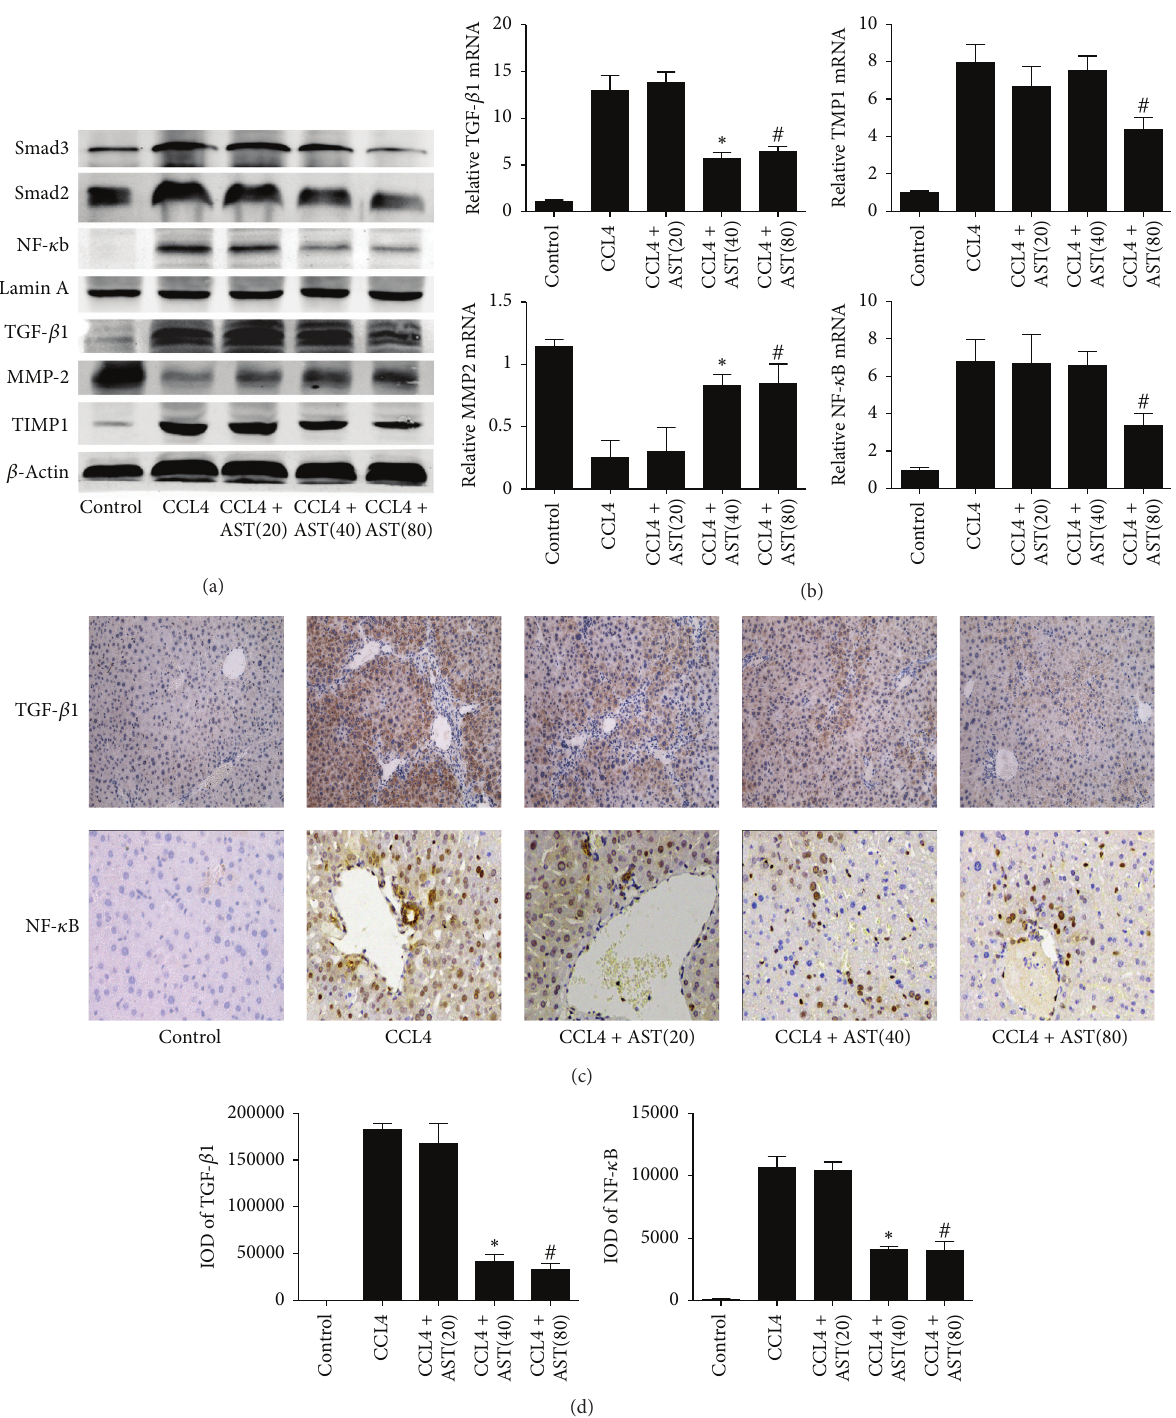
Figure 4: Effects of astaxanthin on expression of TGF- 𝛽 1, MMP2, TIMP1, and NF- 𝜅 b. (a) The analysis of western blotting showed that astaxanthin decreased the expression of TGF- 𝛽 1, TIMP1, and NF- 𝜅 b and, contrarily, increased the expression of MMP2 compared to CCL4 group. (b) The mRNA level of TGF- 𝛽 1 was decreased by astaxanthin (40mg/kg and 80mg/kg), and the mRNA levels of TIMP1 and NF- 𝜅 b were decreased with the dose of 80 mg/kg. However, the mRNA levels of MMP2 were increased by astaxanthin (40mg/kg and 80 mg/kg) compared to CCL4 group. Data are expressed as mean ± SD ( 𝑛 = 7 , ∗ 𝑃 < 0.05 for CCL4 + AST(40) versus CCL4, # 𝑃 < 0.05 for CCL4 + AST(80) versus CCL4). (c) The area of positive cells of TGF- 𝛽 1 was significantly decreased by astaxanthin (40mg/kg and 80mg/kg) stained by immunohistochemistry (original magnification: ×200 ). The expression of NF- 𝜅 B in nuclei decreased obviously with astaxanthin (40 mg/kg and 80 mg/kg) treatment (original magnification: ×400 ). (d) The IODs of TGF- 𝛽 1 and NF- 𝜅 b were analyzed by Image-pro Plus 6.0. There existed a significant decrease with astaxanthin (40mg/kg and 80 mg/kg) treatment ( 𝑛 = 7 , ∗ 𝑃 < 0.05 for CCL4 + AST(40) versus CCL4, # 𝑃 < 0.05 for CCL4 + AST(80) versus